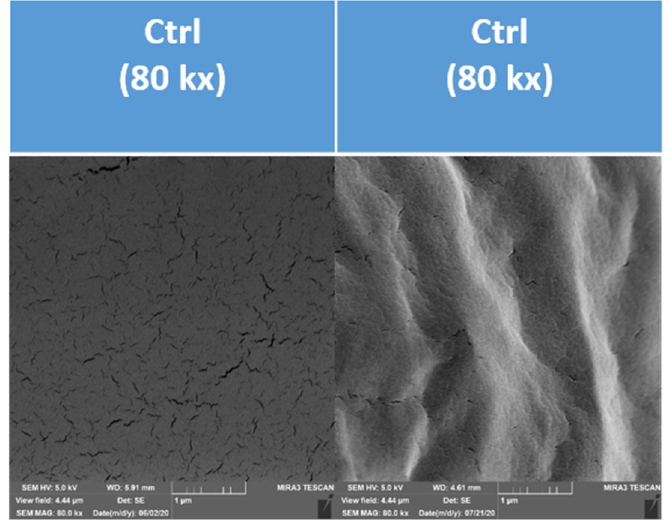
Figure 8. Effect of processing on the microscopic structure of the control sample of an edible coating. ( the left picture ) A coating formed on a strip. ( the right picture ) A coating formed outside a strip.